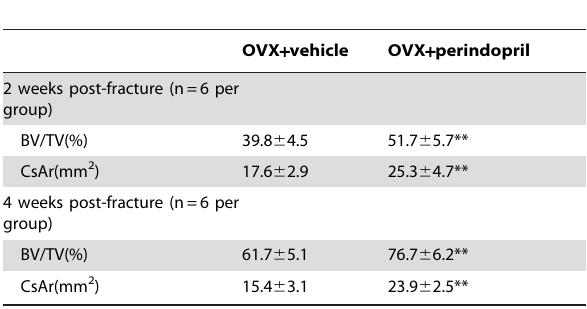
Table 2. Micro-CT based histomorphometry of the fractured tibiae.